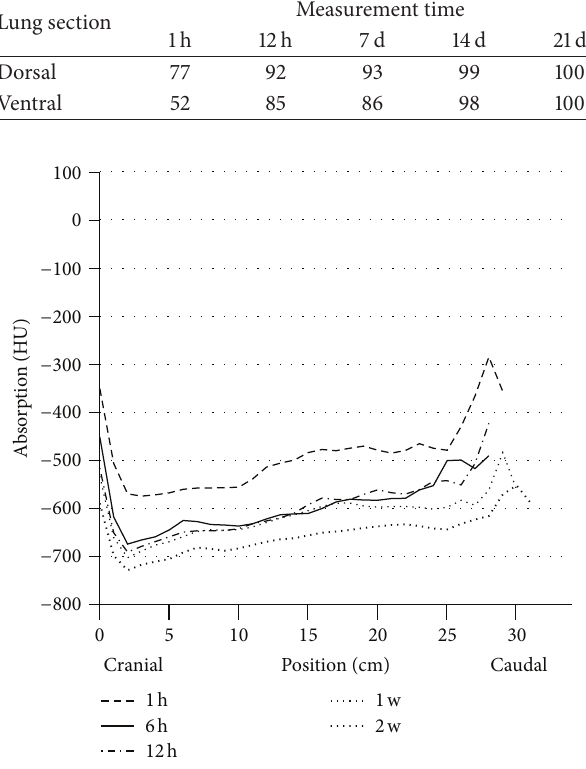
Figure 7: Circulation of the dorsal lung parenchyma in HE of vital calves (group A 𝑛 = 15 ) during the entire research